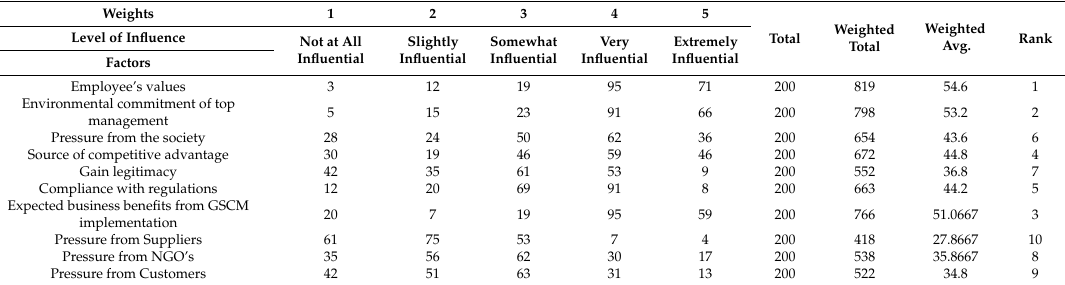
Table 4. Factors leading to the development of green supply